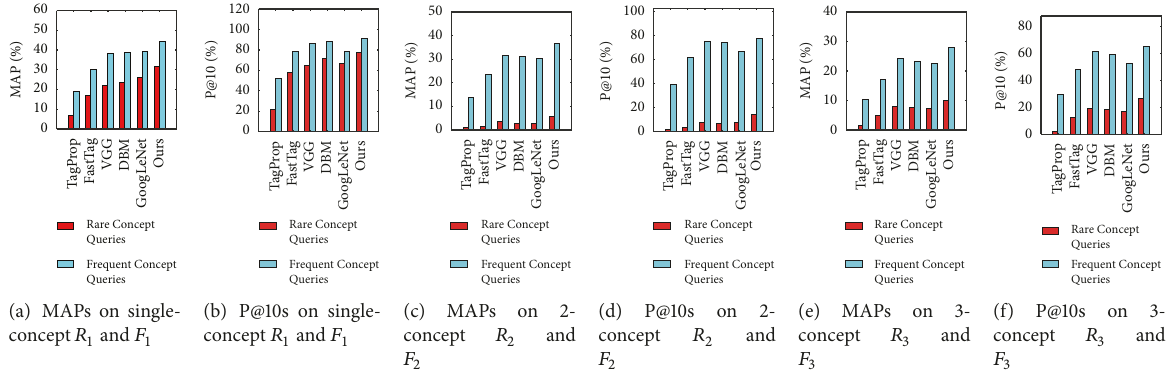
respectively, denoted by 𝑅 1 , 𝑅 2 , and 𝑅 3 . In the second group, the top-50 frequent single concepts, the top-100 frequent 2- concepts, and the top-100 frequent 3-concepts from Q are, respectively, chosen as the set 𝐹 1 of single-concept frequent query, a set 𝐹 2 of the 2-concept frequent query, and a set 𝐹 3 of the 3-concept frequent